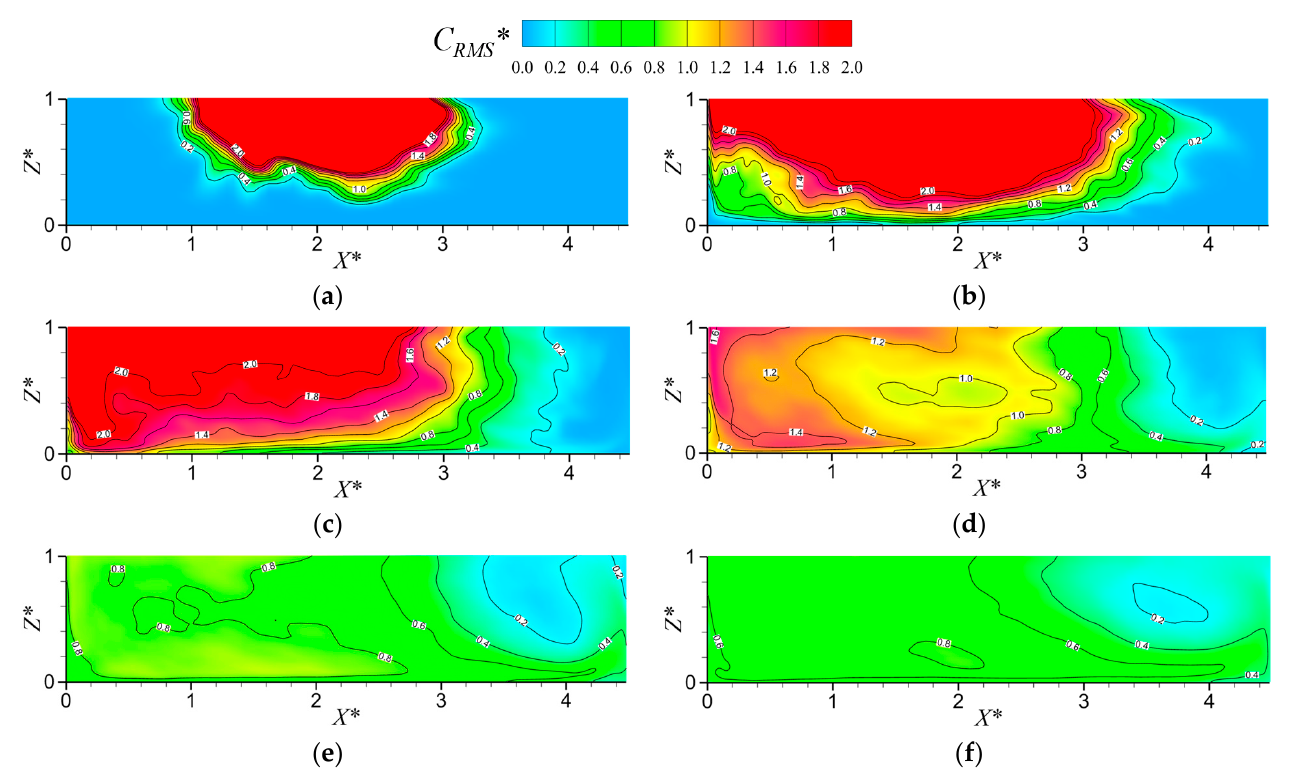
Figure 17. The dimensionless RMS fluctuations of concentration C RMS * in S3. (From left to right denotes from inner bank to outer bank). ( a ) Section #02 in Case S3; ( b ) Section #03 in Case S3; ( c ) Section #04 in Case S3; ( d ) Section #05 in Case S3; ( e ) Section #06 in Case S3; ( f ) and Section #07 in Case S3.